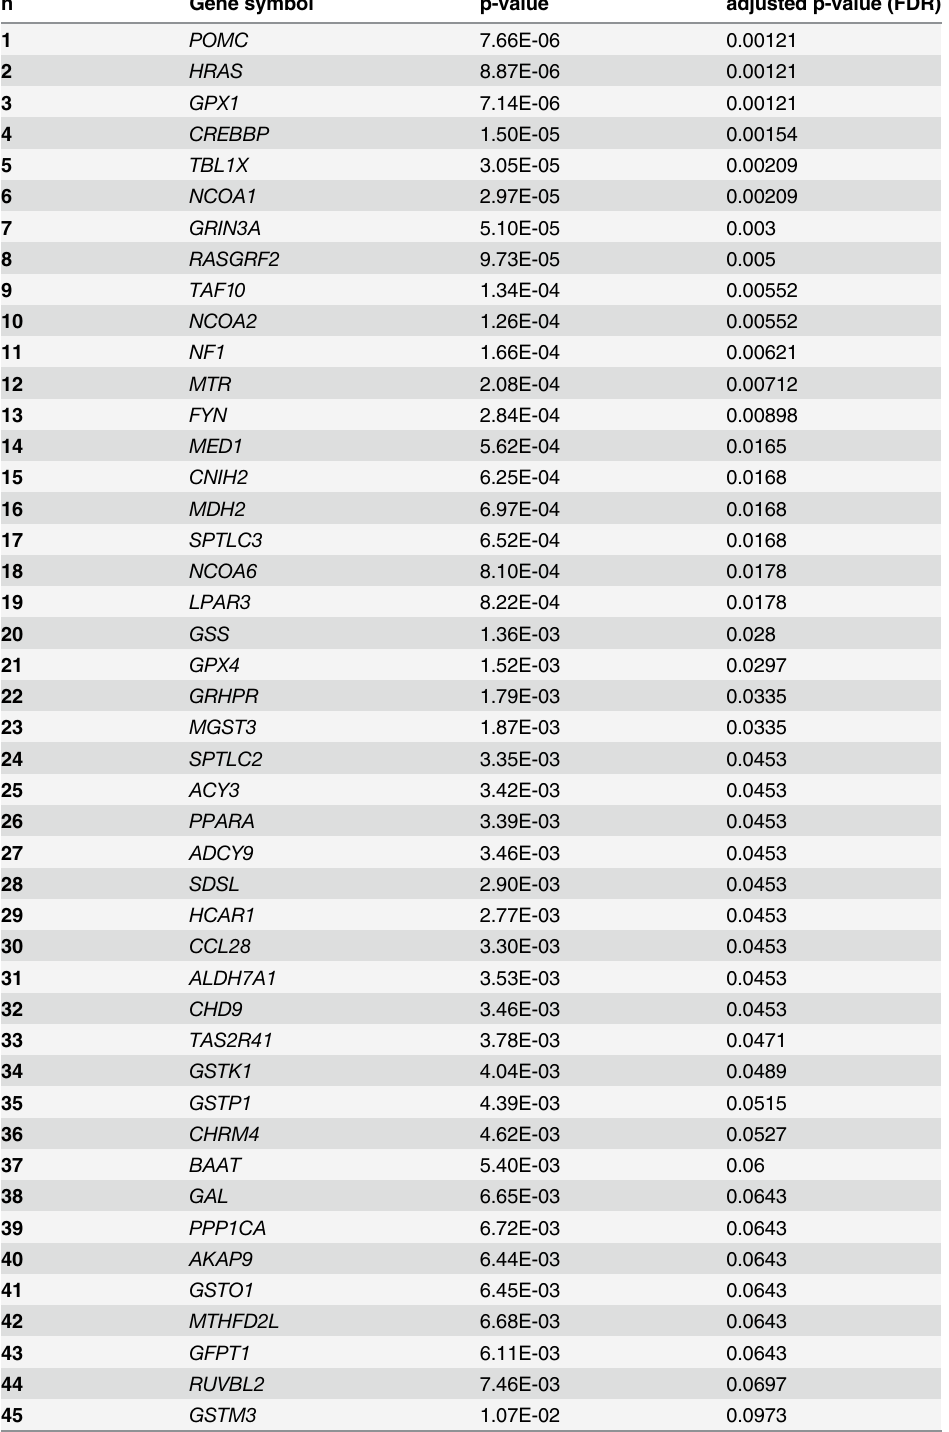
Table 2. Gene expression and weight